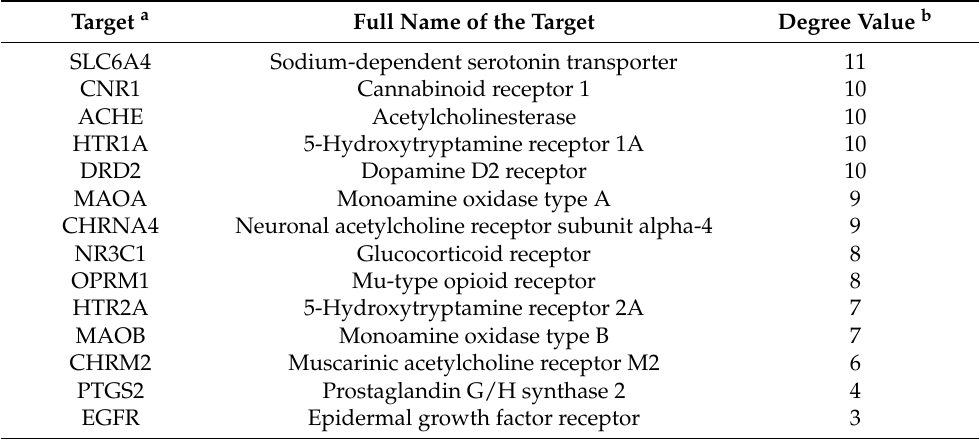
Table 4. Ranking of all the 14 core targets in the PPI core